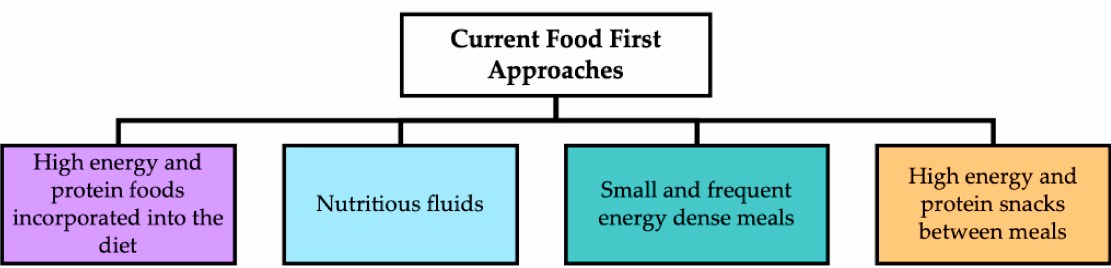
Figure 1. Commonly used strategies to improve nutritional intake in older adults at risk of malnutrition (adapted from [12]).